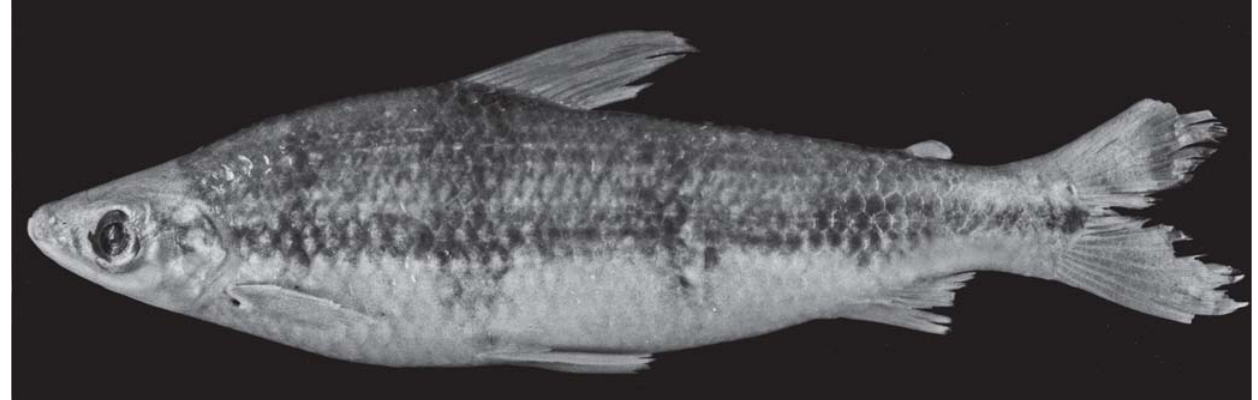
Fig. 20. Adult specimen of Laemolyta proxima , MZUSP 61642, 180.3 mm SL; Brazil, Roraima, rio Branco, Marará, Paraná-praia.